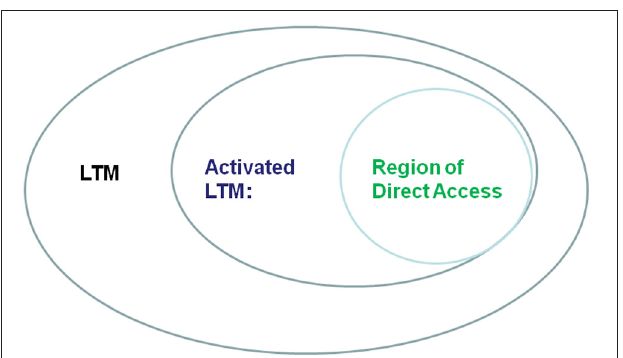
FIGURE 1 | A schematic representation of (our interpretation of) Oberauer’s (2001, 2002) model. According to this model, working-memory comprises activated long-term memory representations. The region of direct-access consists of novel bindings between a sub-group of activated long-term memory representations.